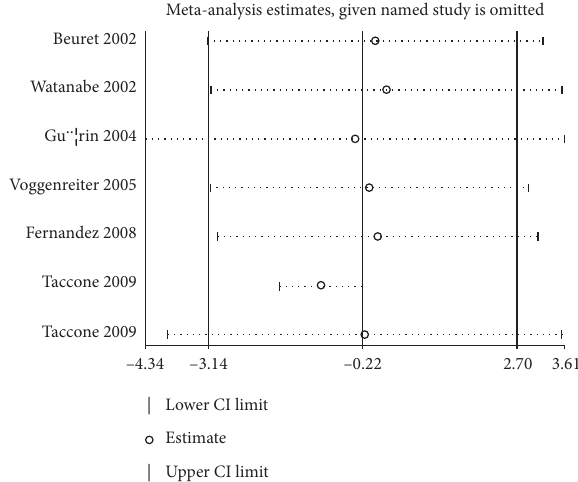
Figure 5: Sensitivity for duration of mechanical